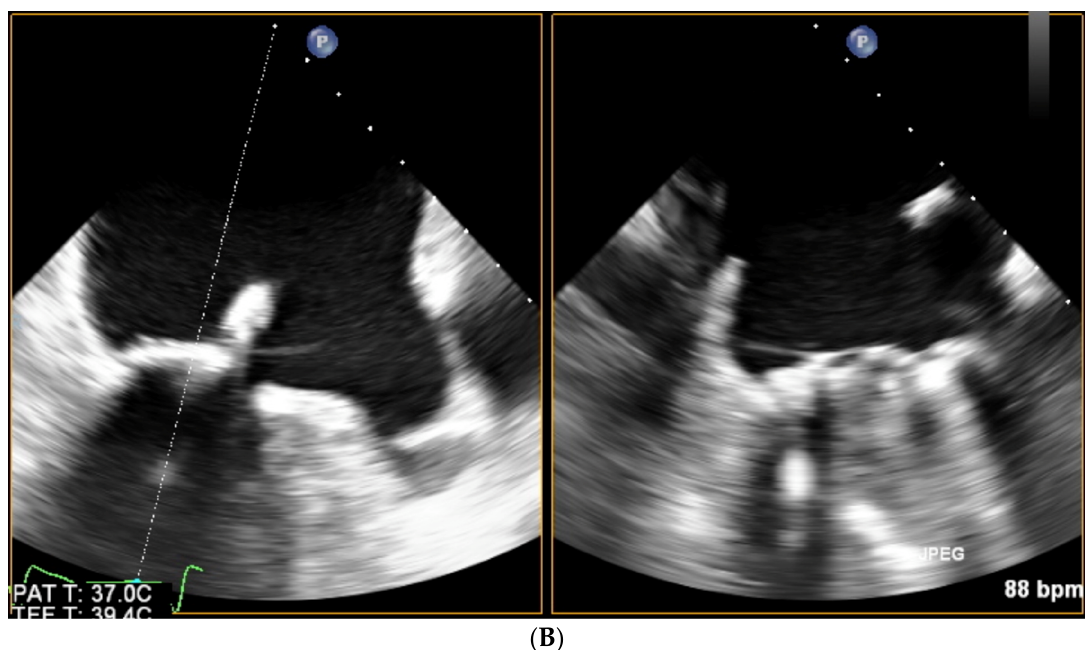
Figure 7. ( A ) Mitral PVL closure, TOE biplanar imaging allowing for simultaneous controlling of the plug implantation (left panel) and preserved prosthetic discs opening (right panel—diastole, discs symmetrically opened). ( B ) Mitral PVL closure, TOE biplanar imaging allowing for simultaneous controlling of the plug implantation (left panel) and preserved prosthetic discs closing (right panel—systole, discs symmetrically closed).